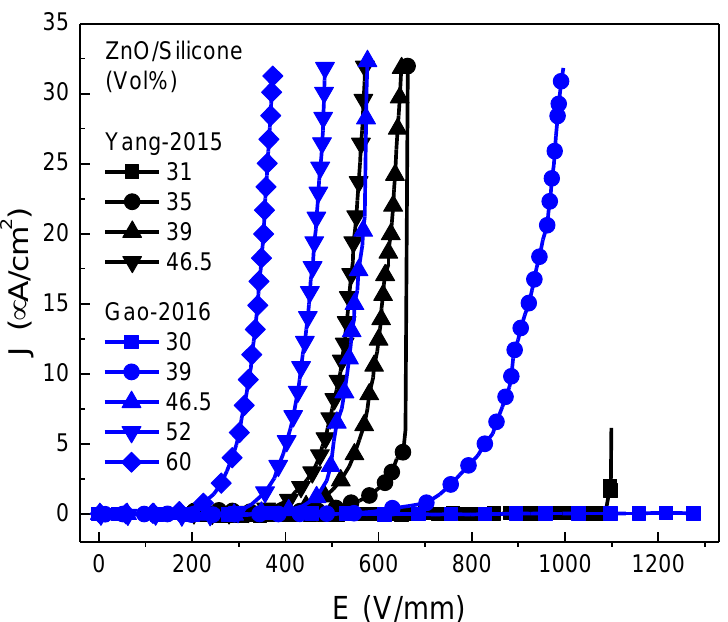
Figure 8. J–E characterization of silicone rubber composites with varying ZnO filler concentrations. Data extracted from [54,55].